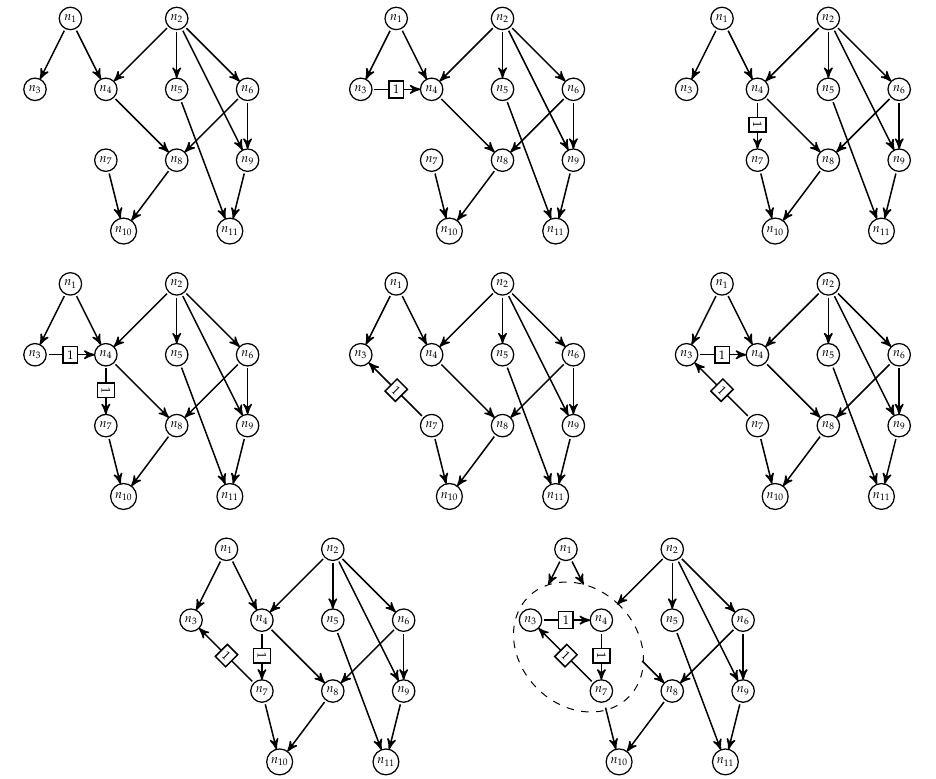
Figure 6. Representation of partition of the probabilistic space.